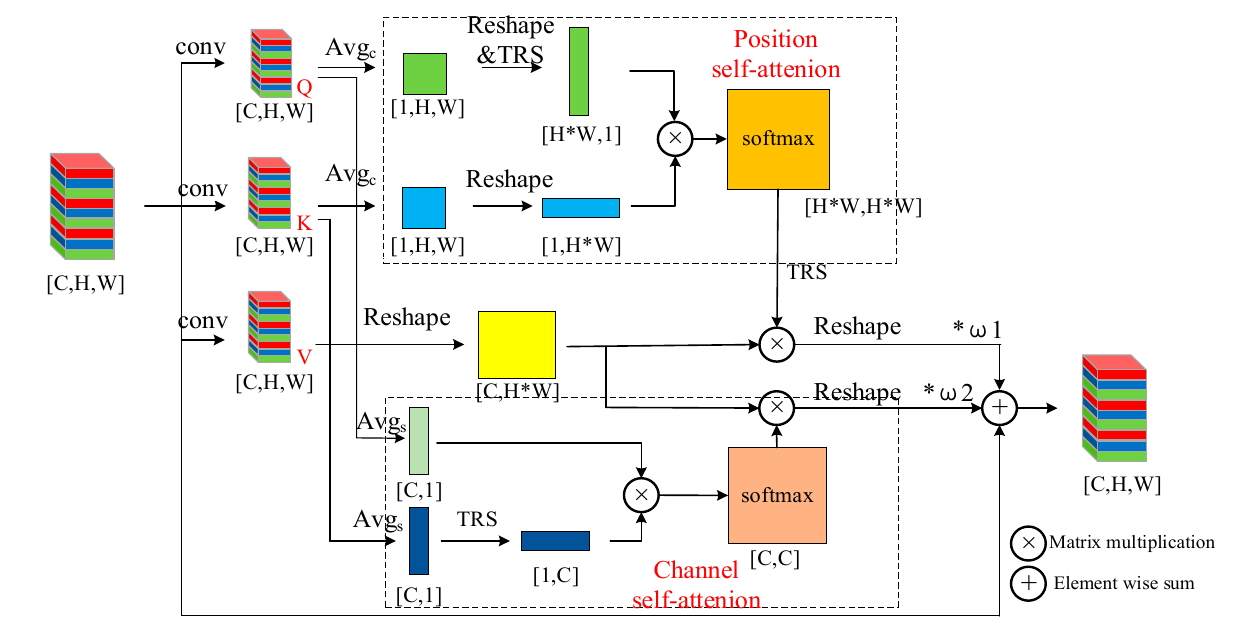
Figure 5. PCSA layer structure.